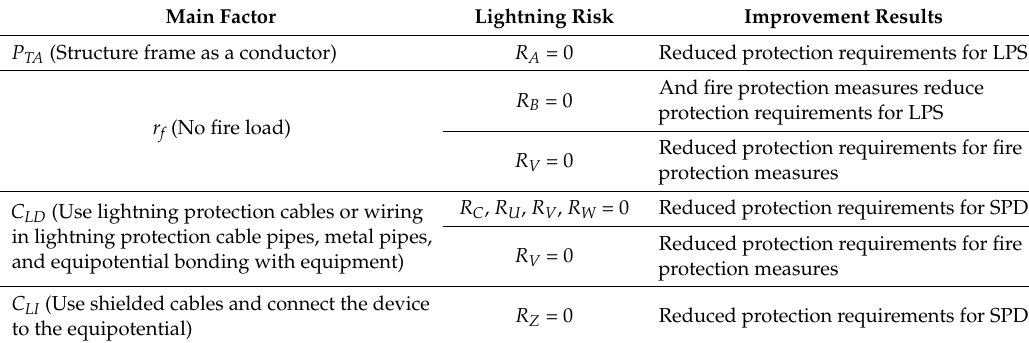
Table 4. The main point for the lighting